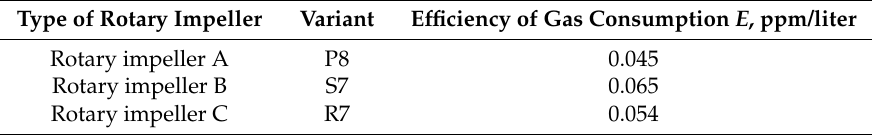
Table 4. Efficiency of gas consumption for studied rotary impellers, for variants P8, S7 and R7. Type of Rotary